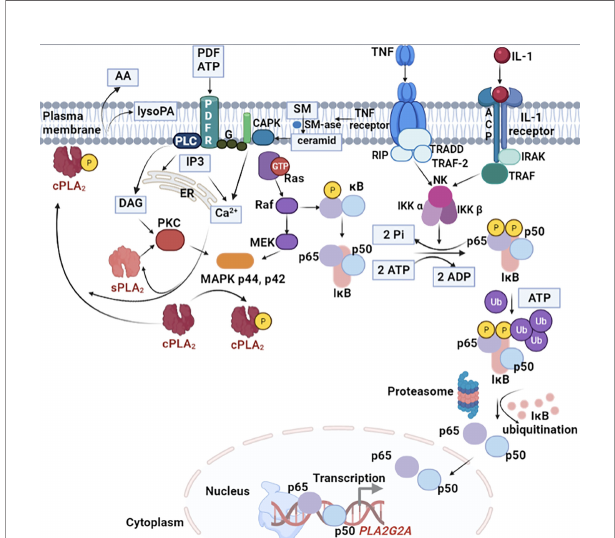
FIGURE 4 | Cellular signalling pathway crosstalk induced by IL-1 for sPLA2- IIA expression. IL-1 induce transcription and secretion of sPLA2-IIA through a mechanism involving the MAPK. A few hours after the enzyme secretion, the signalling pathway is followed by the generation of prostanoids. The induction process is time-dependent and generally occurs after an initial lag period of about 8 h. Both IL-1 and TNF- a stimulate gene transcription and stabilize its RNA. In certain cells, such as for example macrophages, the expression sPLA2-IIA is strongly induced by the two cytokines stimulation under lipopolysaccharides (LPS) action. The MAPK cascade is activated in response to several cytokines, in particular TNF- a and IL-1, and is associated with the activation of nuclear transcriptional factor kB (NF-kB) and several serine/ treonin kinases. TNF- a and IL-1 initiates the hydrolysis of sphingomyelin from the plasma membrane. The formed ceramide activates a speci fi c protein kinase (CAPK) on which the MAPK cascade initiation relies on. While the MAPK pathway occurs in the cytosol, the processes that initiate it take place inside the plasma